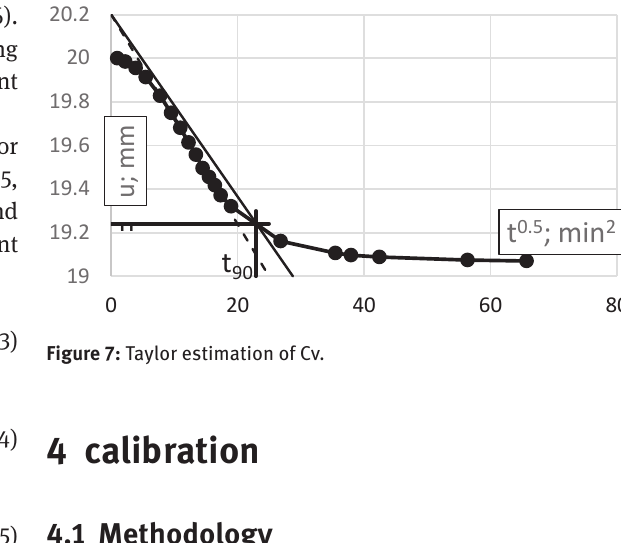
Figure 7. Taylor estimation of Cv Figure 7: Taylor estimation of